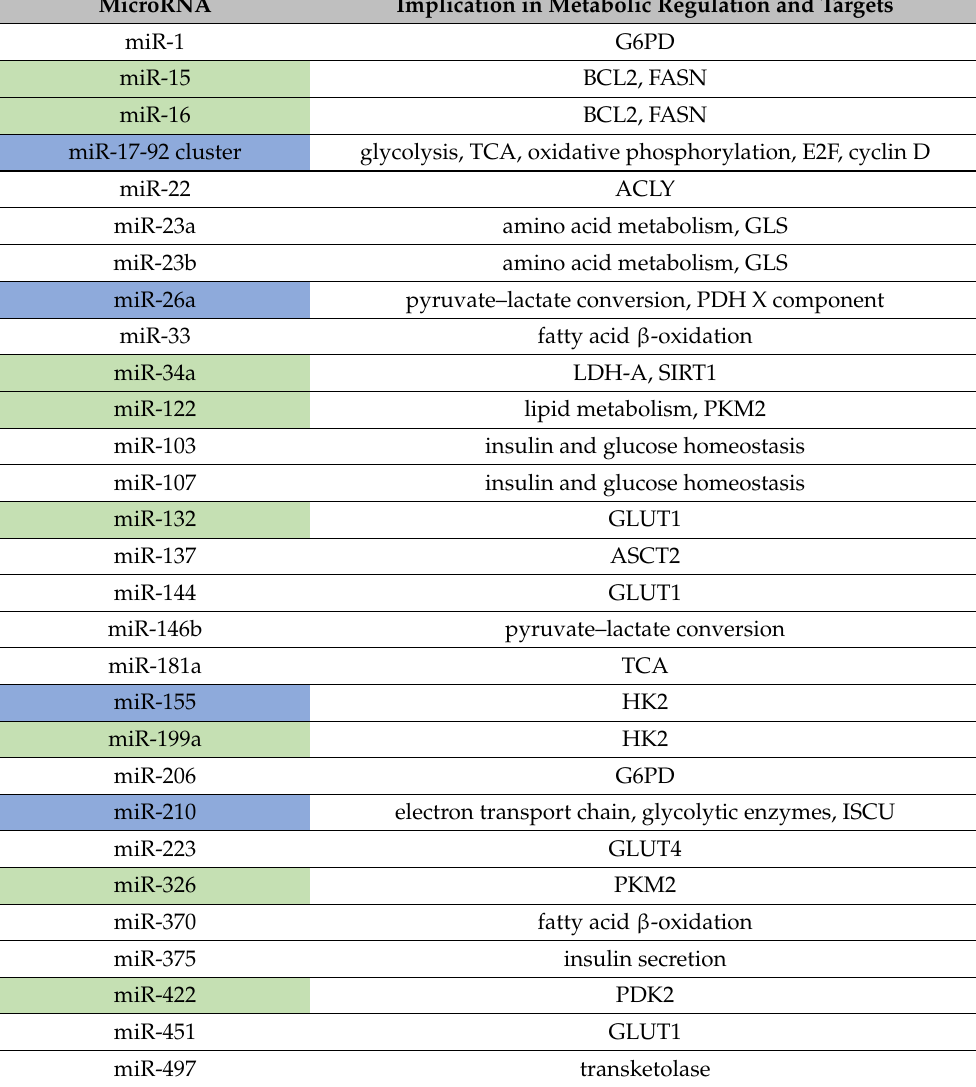
Table 1. MicroRNAs are involved in both the maintenance of metabolic homeostasis and the metabolic reprogramming of cancer cells. Examples for Warburg-promoting and anti-Warburg microRNAs are highlighted with blue and green background,